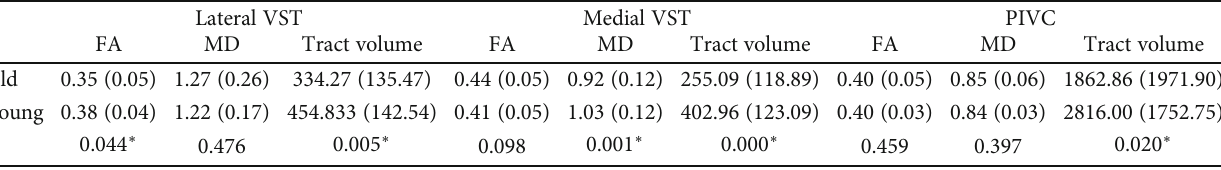
Table 2: Comparison of DTI parameters in lateral VST and medial VST and PIVC between young and old healthy adults. Lateral